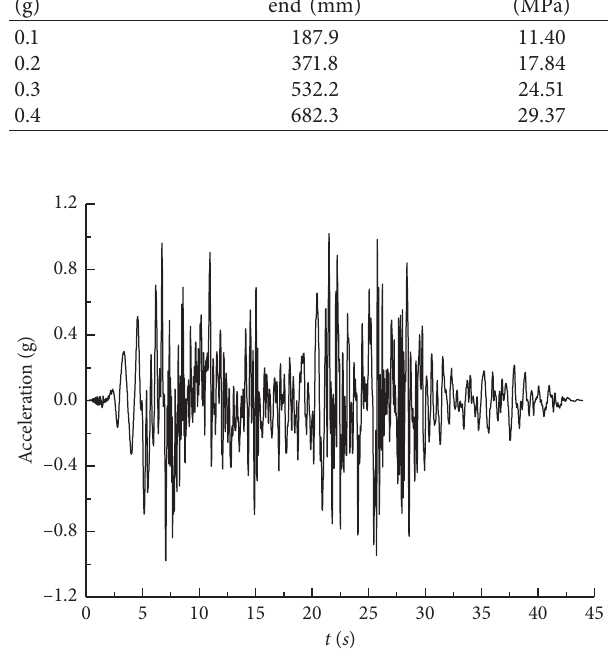
Figure 9: Input seismic